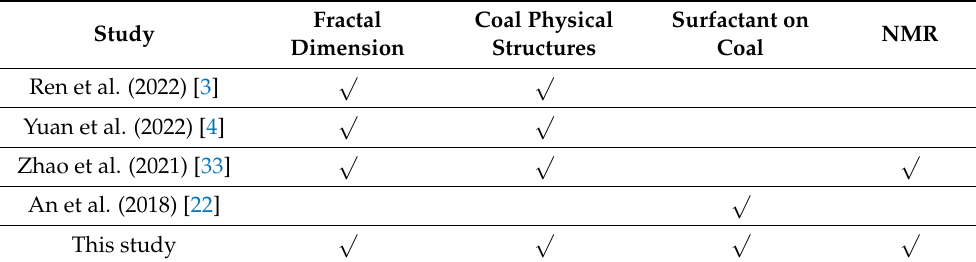
Table 1. Summary of most relevant